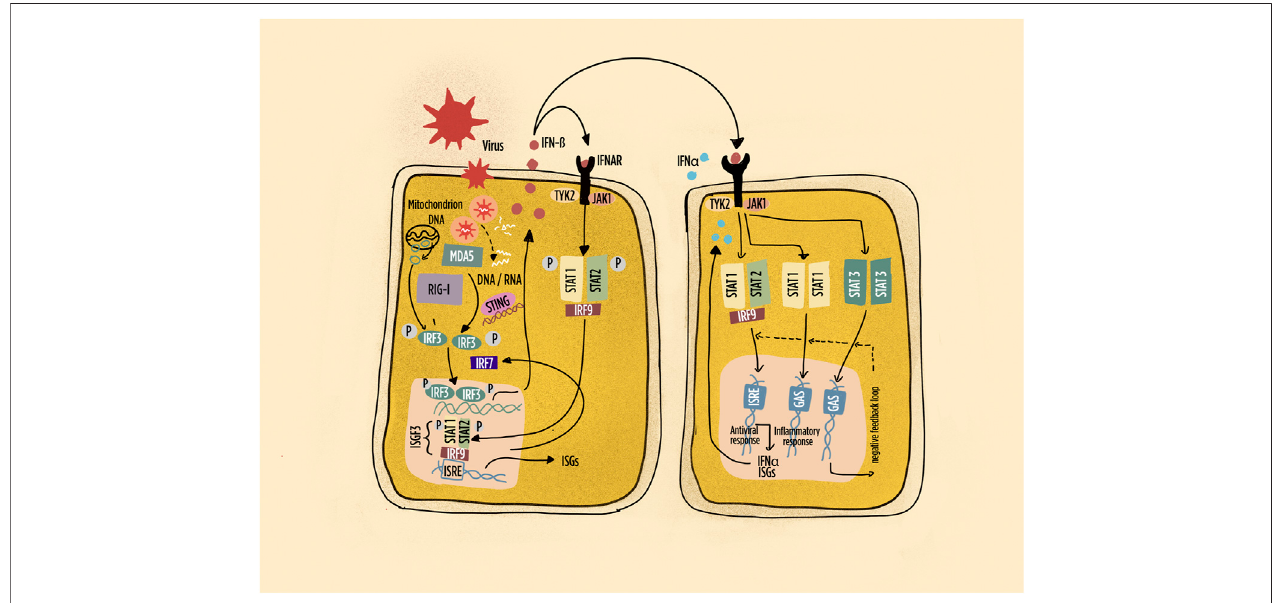
FIGURE2| Schematicrepresentationofpathwaysleadingtointerferon(IFN)productionandIFNresponsesinmanycelltypes.Highlightedtheintracellularsensors of viral and endogenous DNA/RNA; the main interferon regulatory factors; the primary response characterized by IFN-beta production with autocrine and paracrine responses. Abbreviations: IFNAR: interferon-alpha/beta receptor; ISGF: interferon-stimulated gene factor; ISRE: interferon-stimulated responseelement;IRF: interferon regulatory factor; JAK: Janus kinase; MDA5: melanoma differentiation – associated protein 5; RIG-1: retinoic acid inducible gene-1; STAT: signal transducer and activator of transcription; STING: stimulator of interferon genes; Tyk: tyrosine kinase. Dashed line: negative feedback response.